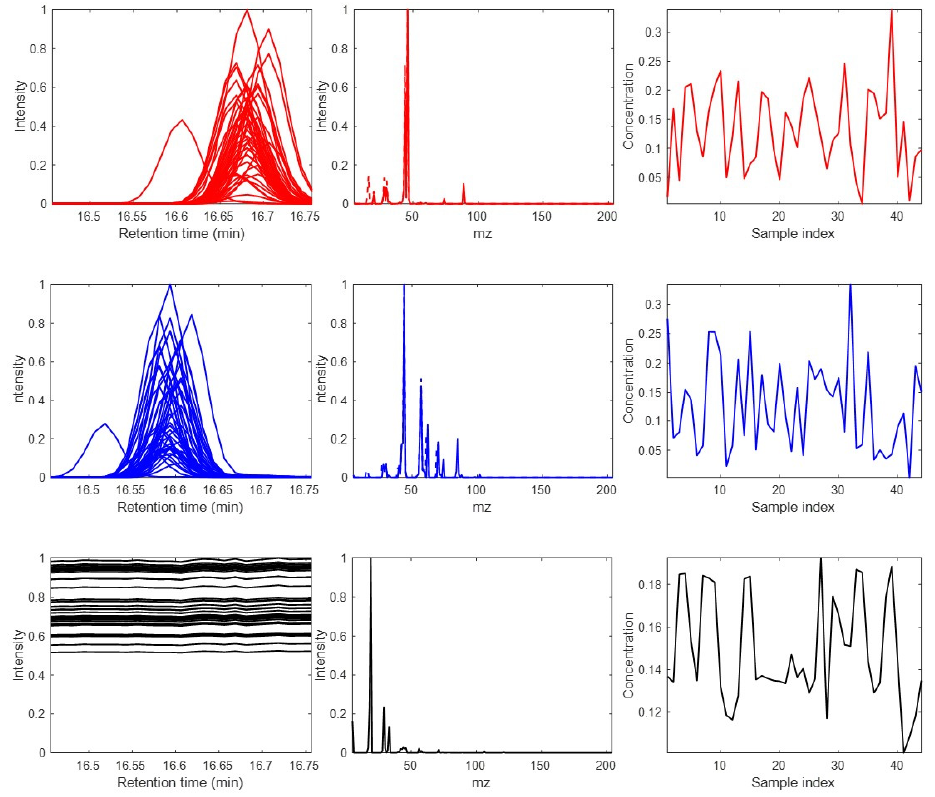
Figure 5. Elution, spectra, and sample profiles of the three components resolved by MCR-ALS mixed trilinear model 2,2,1 in the analysis of the wine GC-MS dataset. Table 2. Comparison of results obtained by ATLD, PARAFAC, PARAFAC2, DNTD and different variants of MCR-ALS in the analysis of the wine GC-MS dataset. In bold red are worse recovered profiles with r 2 values below 0.9. See Equations (7)–(10) for the meaning of R 2 , lof, r 2 and angle. See end of Section 2.2 for the meaning of the different MCR-ALS variants.